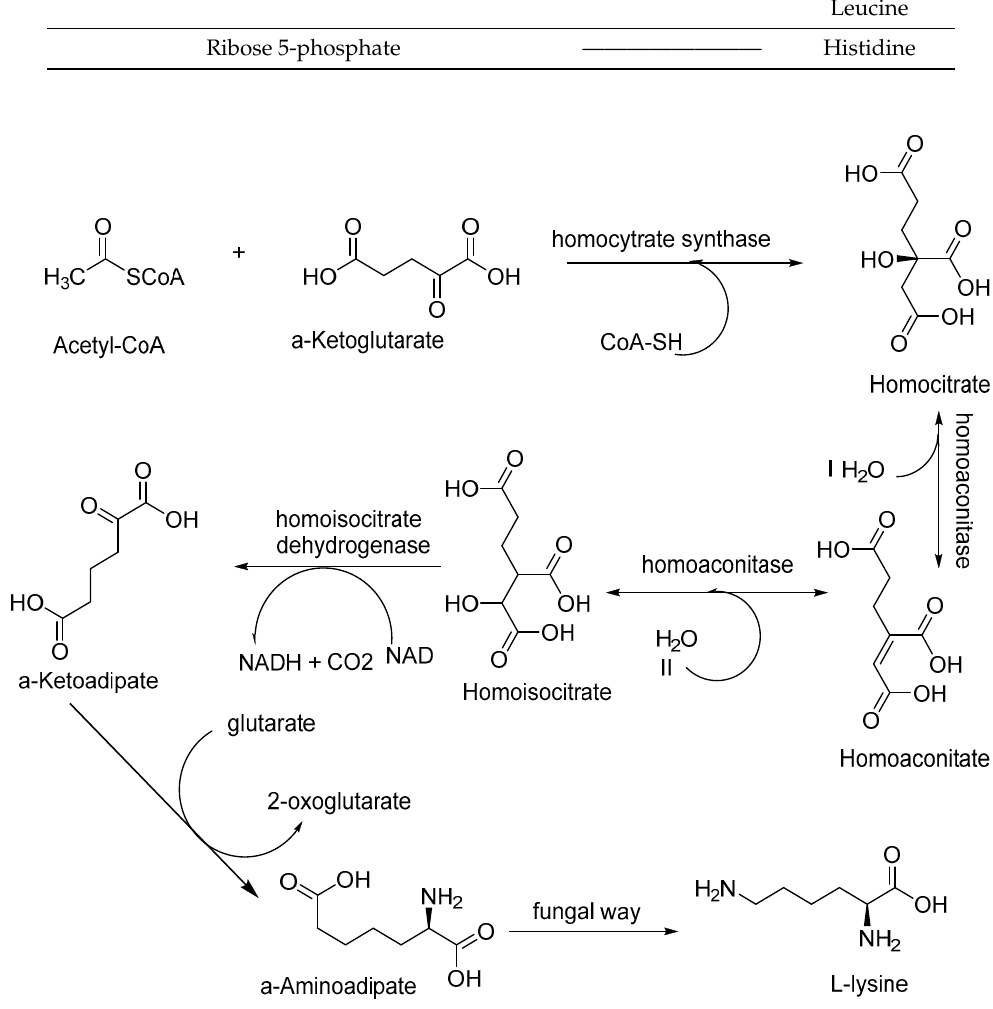
Figure 5. Schematic representation of L ‐ lysine biosynthesis via α‐ aminoadipate pathway. It illustrates that precursors acetyl ‐ CoA and α‐ ketoglutarate in the presence of homocitrate synthase